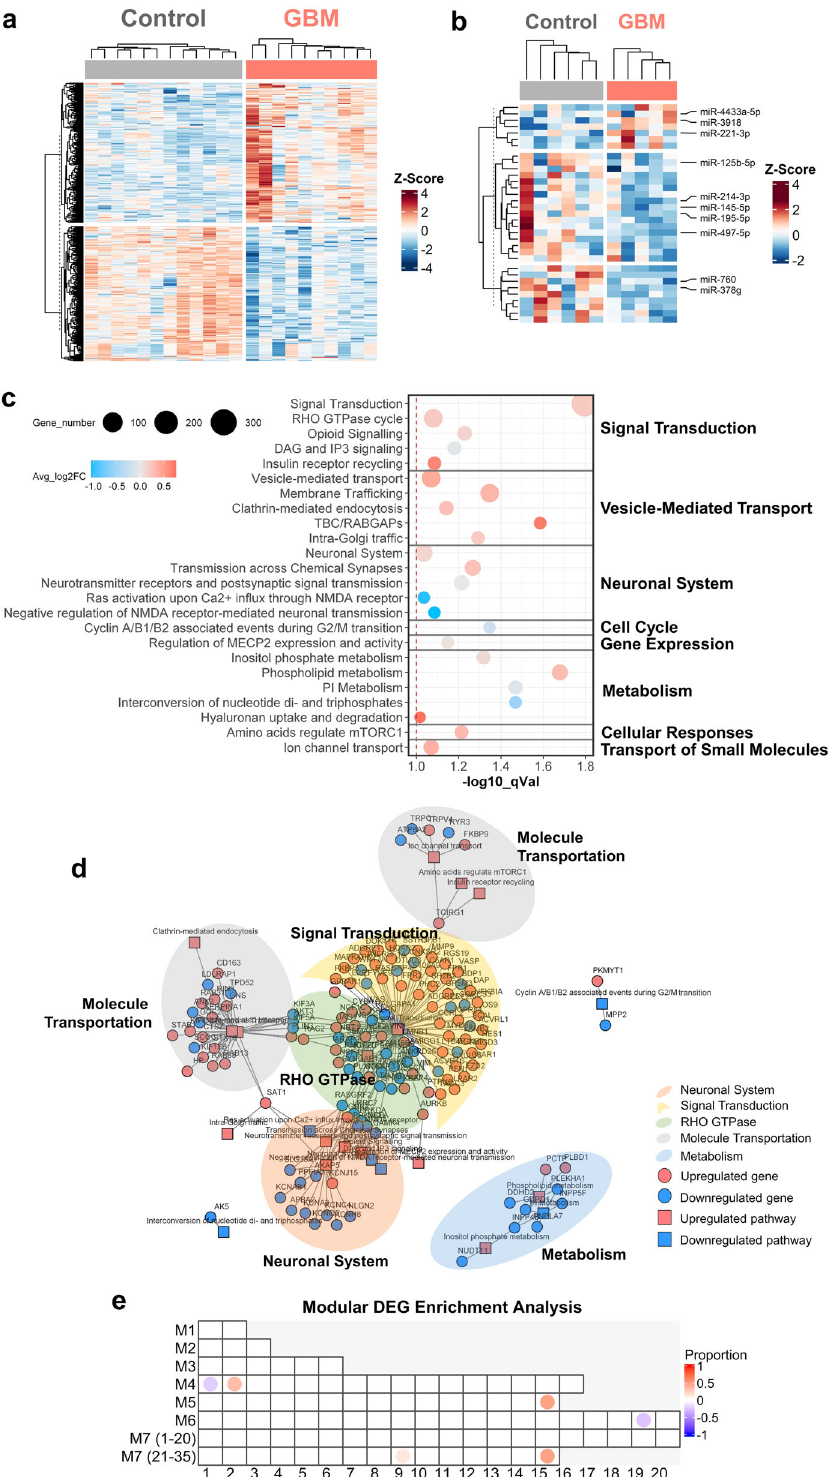
Fig. 3 Gene expression pro fi ling and integrated functional network analyses. a Heatmap of differentially expressed mRNAs that survived FDR ≤ 0.05 and FC ≥ 2.0. b Heatmap of log2 normalized counts for miRNAs that survived P ≤ 0.05 and FC ≥ 2.5. For each gene in a or b , the mean of the control group was subtracted. Hierarchical clustering was performed for the heatmaps. c Dot plot showing the functional annotation of overlapping Reactome signaling pathways in both GBM blood RNA-seq results and GBM tissue datasets. The x -axis is the − log10 q-value for each pathway. The red dotted line represents the − log10 transformed q- values (FDR) of 0.1. d Network connecting DEGs and major overlapping pathways shown in a . e DEG enrichment analysis using the modular enrichment method. The proportions of DEGs in modules are indicated by a color gradient ranging from blue (100% of transcripts decreased) to red (100% of transcripts increased). C control, P GBM